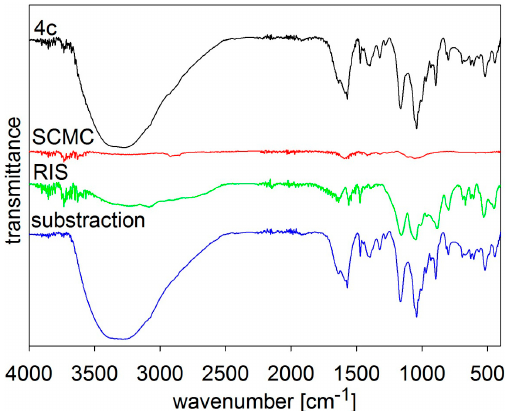
Figure 5. MIR spectra of risedronate (RIS), sodium carboxymethyl cellulose (SCMC) and risedronate nanoparticles stabilized with 5% concentration of sodium carboxymethyl cellulose (Sample 4c ) and differential